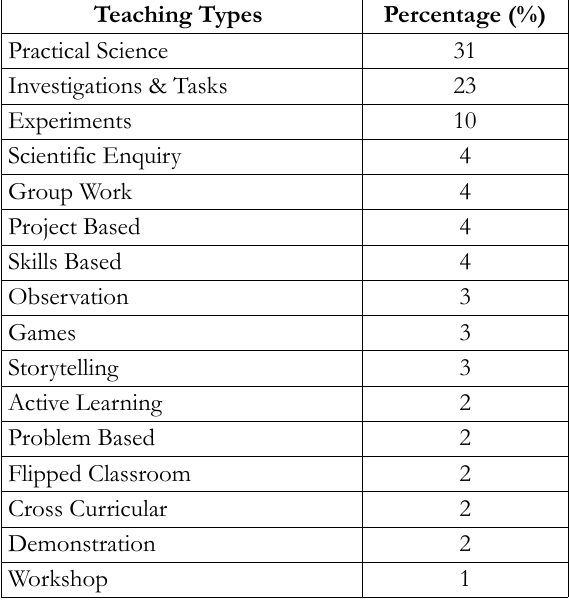
Table 3. Percentage of responses from teachers regarding teaching types (Questionnaire)